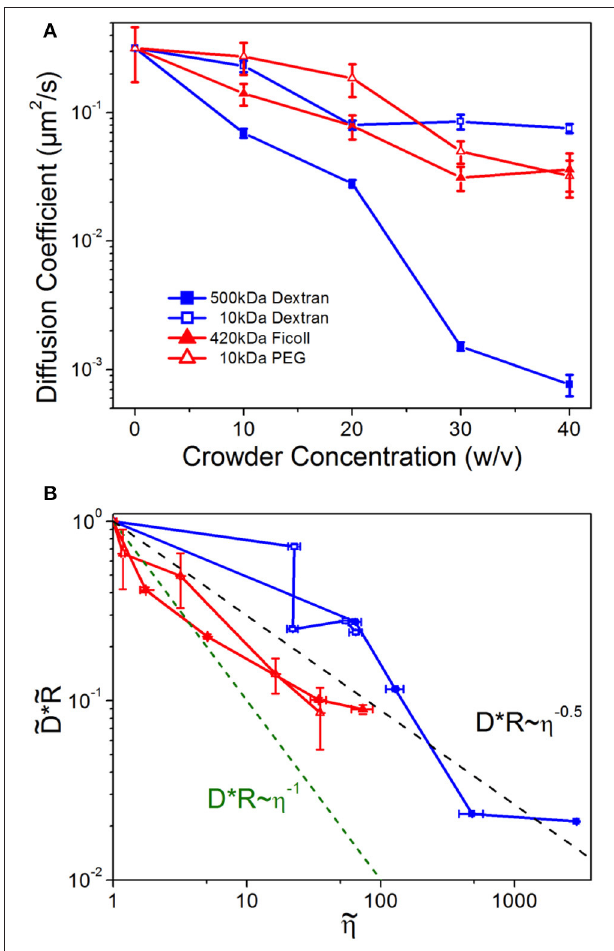
FIGURE 3 | DNA diffusion decreases with increasing crowder concentrations, but universally diffuses faster than predicted by Stokes-Einstein scaling. (A) Diffusion coefficients for DNA crowded by varying concentrations (w/v) of 500 kDa dextran (blue filled squares), 10 kDa dextran (blue open squares), 420 kDa Ficoll (red filled triangles), and 10 kDa PEG (red open triangles). (B) DNA diffusion coefficients D scaled by the empirical DNA size R , vs. crowded solution viscosity η . All quantities are normalized by the corresponding buffer condition value, which we denote by tilde ( ˜ D , ˜ R , ˜ η ). The dashed green line indicates the SE relation DR ∼ η − 1 , while the black dashed line shows the average empirical scaling, D ∼ η − 0.5 . Note that nearly every ˜ D ˜ R value lies above the predicted Stokes-Einstein